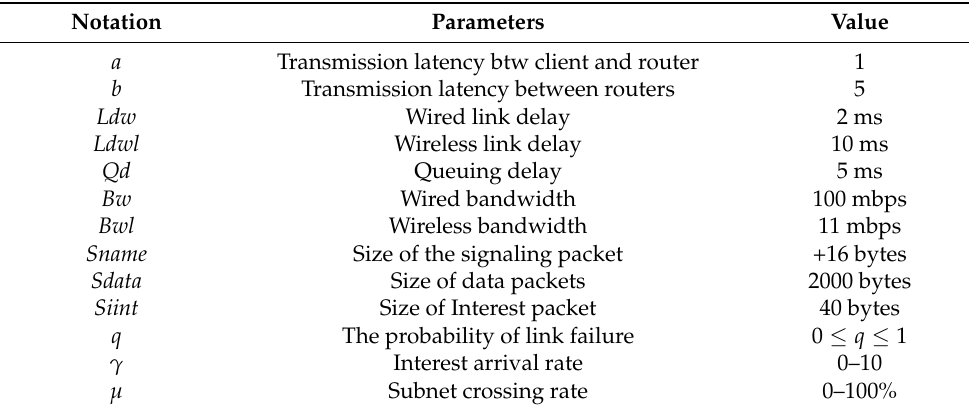
Table 1. Numerical Analysis Parameters and